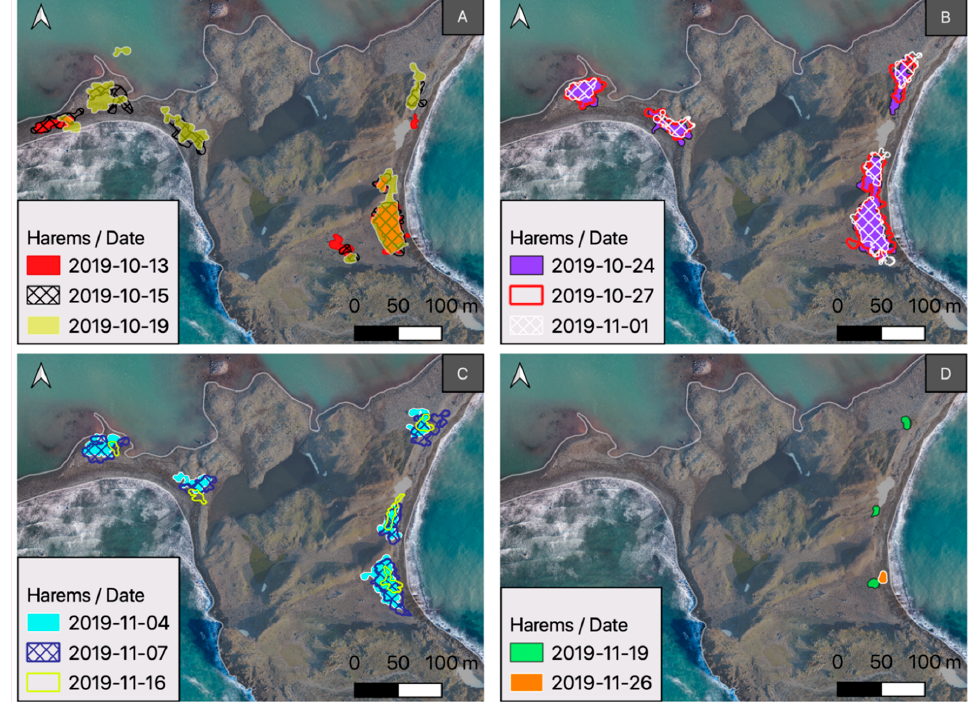
Figure 4. Localizations of all harems within the area of Patelnia Point divided into four main periods of time: ( A ) formation; ( B ) haul-out; ( C ) weaning; and ( D ) breakup. The base map was obtained for November 20, and the harem in the top left corner on October 19 was identified on sea ice, which covered the cove on that day.